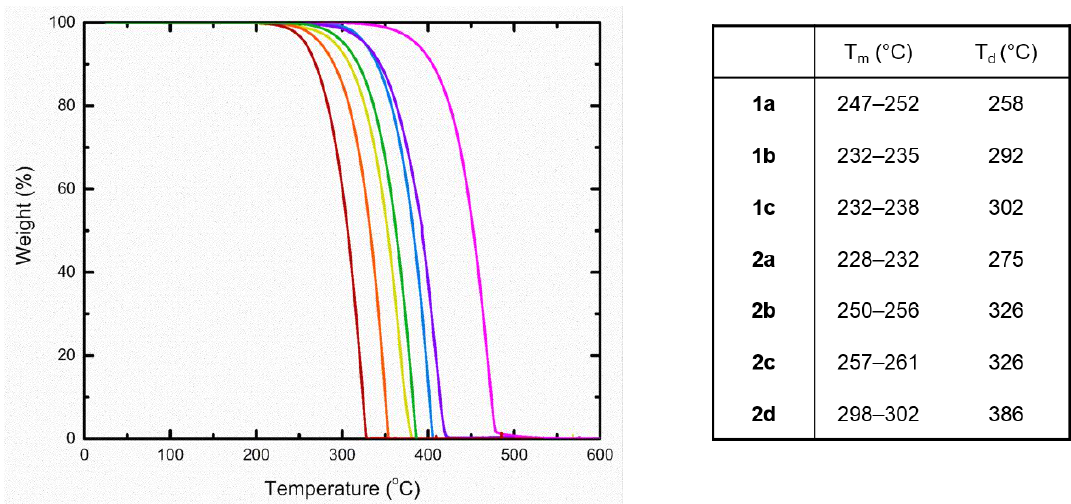
Figure 3. Thermogravimetric analysis curves from left to right: 1a (red), 1b (yellow), 1c (green), 2a (orange), 2b (purple), 2c (blue), and 2d (magenta) and their associated T m and T d (corresponding to 5% weight loss).